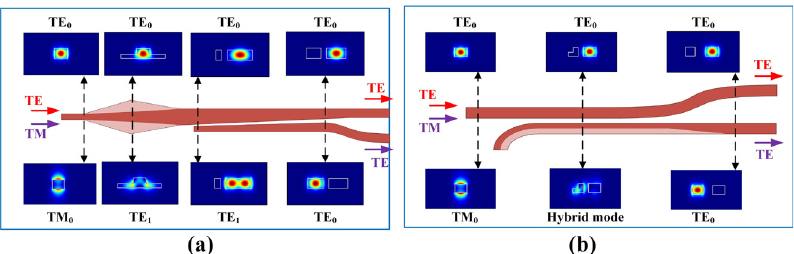
Figure 15: Schematics of two types of PSRs. (a) higher-order mode conversion: TM 0 is fi rstly converted to TE 1 using a bilevel taper and then to TE 0 through adiabatic coupling; (b) hybrid-mode coupling: TM 0 is converted to TE 0 through the evolution of a hybrid mode. PSRs, polarization splitter-rotators; TE, transverse electric; TM, transverse magnetic.